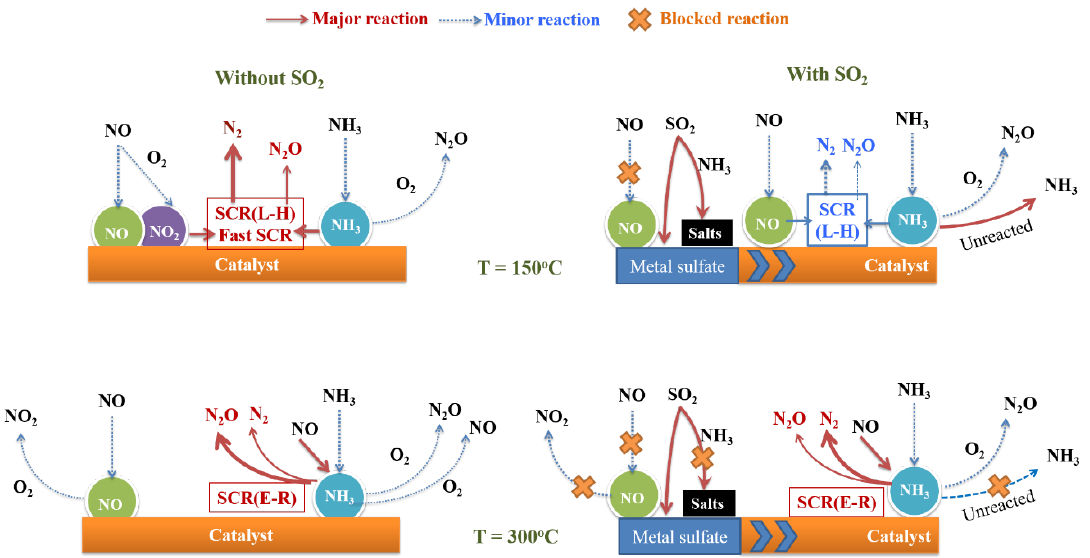
Figure 8. Proposed reaction pathway in the NH 3 -SCR system with/without SO 2 at 150 °C and 300 °C. The reaction pathway was based on inlet NH 3 and NO molar concentration ratio of 1:1.